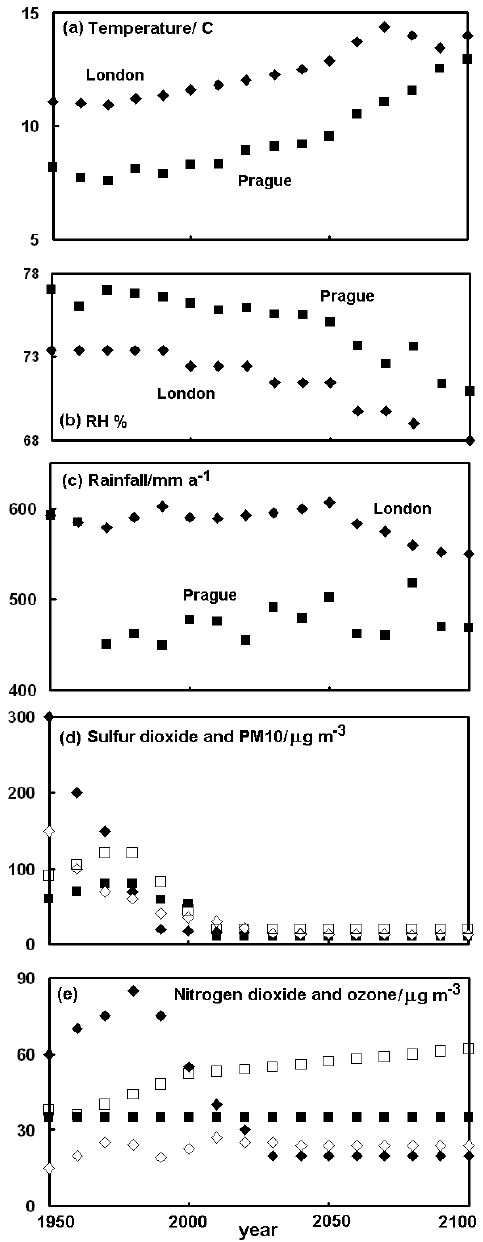
FIGURE 1. (a) Annual average temperatures adopted for London and Prague. (b) Annual average relative humidity adopted for London and Prague. (c) Annual average rainfall (i.e., precipitation less snowfall) adopted for London and Prague. (d) Average SO 2 (filled symbols) and PM 10 (unfilled symbols) concentrations for London (diamonds) and Prague (squares) used in the current study. Historic values of SO 2 and soot are available for London from 1950 and for Prague from 1981[15]. (e) Average NO 2 (filled symbols) and O 3 (unfilled symbols) concentrations used in the current study for London (diamonds) and Prague (squares). Historic values